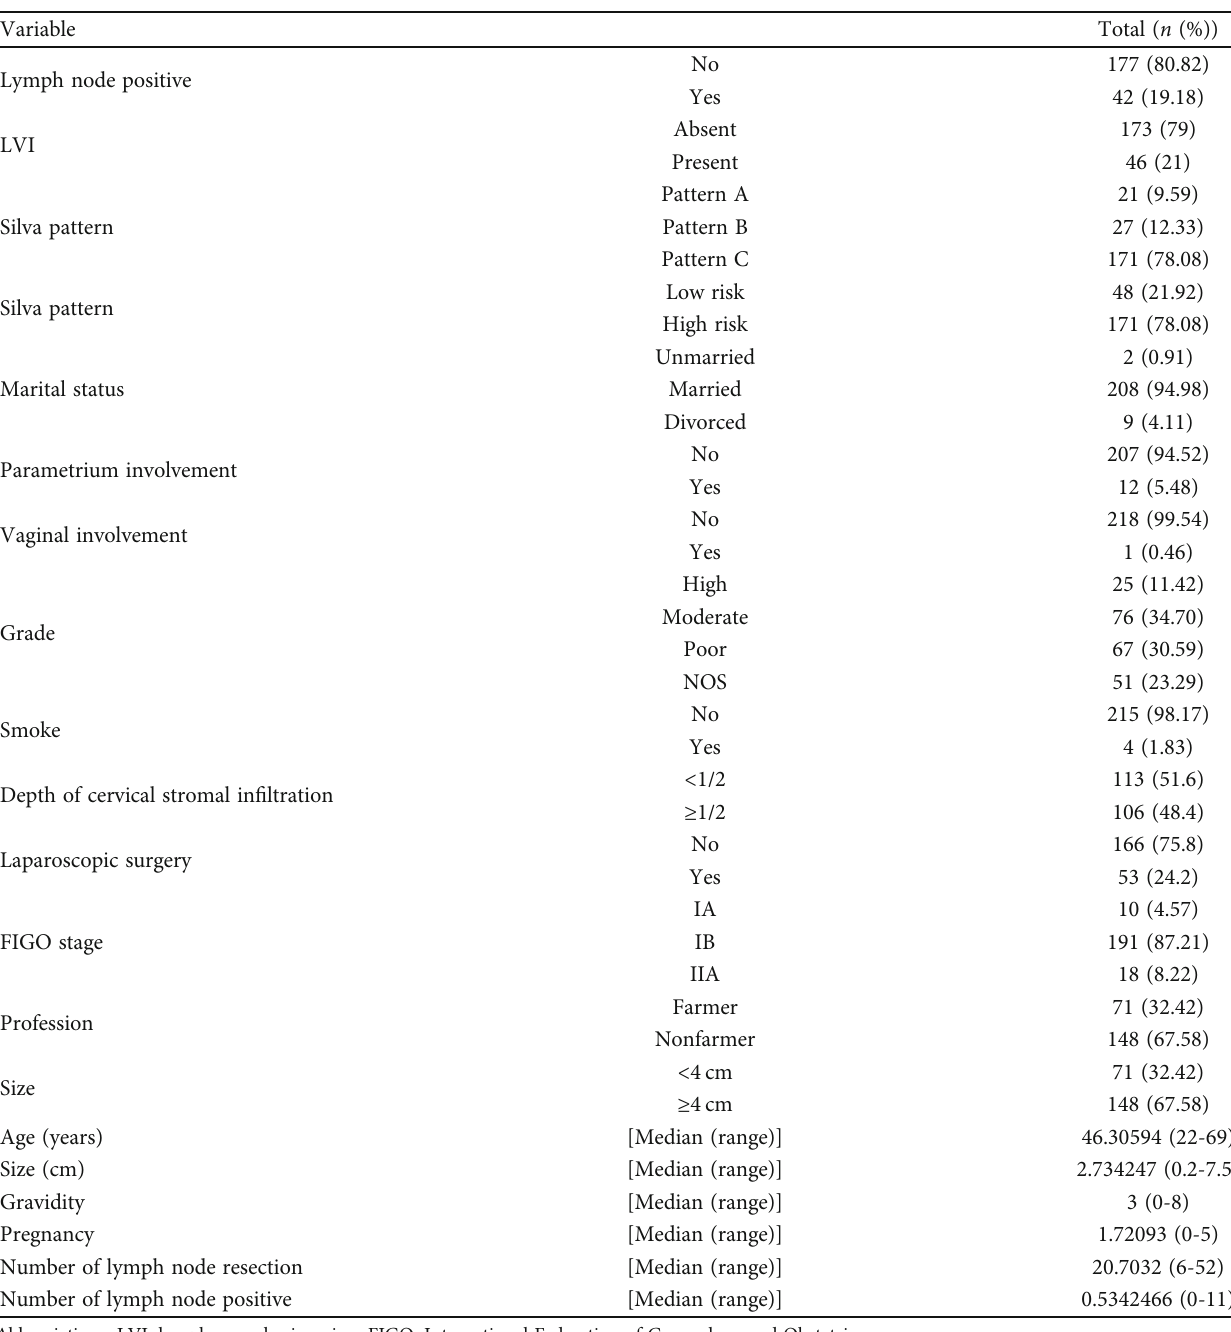
Table 1: Variables of pathologic